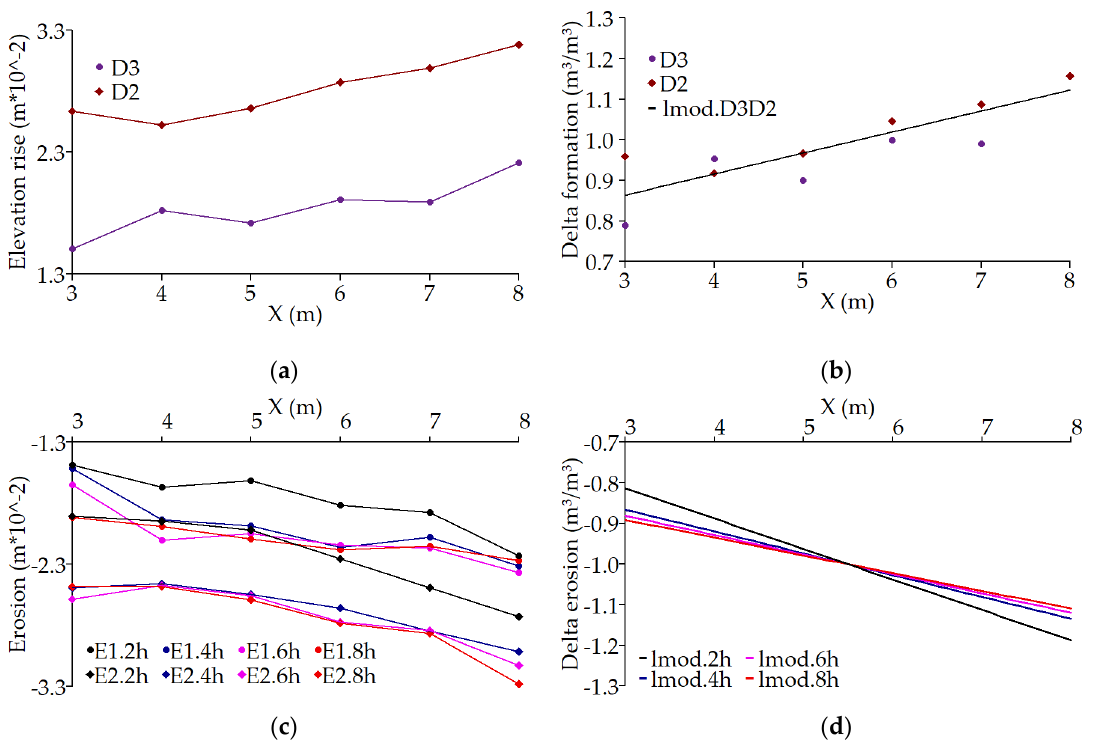
Figure 9. Delta formation and flushing processes as a function of the flow path (x): ( a ) delta elevation rise; ( b ) normalized delta volumes changes per meter in relation to the mean volume change during delta formation; ( c ) delta erosion during flushing experiments for different time durations; ( d ) linear regression models of the normalized erosion volumes changes per meter.